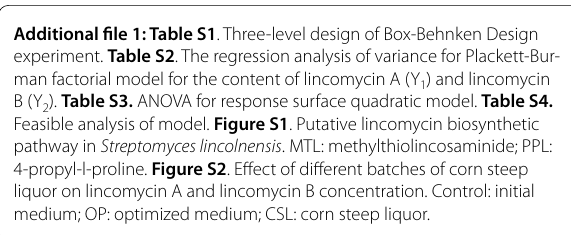
Additional file 1: Table S1 . Three‑level design of Box‑Behnken Design experiment. Table S2 . The regression analysis of variance for Plackett‑Bur‑ man factorial model for the content of lincomycin A (Y 1 ) and lincomycin B (Y 2 ). Table S3. ANOVA for response surface quadratic model. Table S4. Feasible analysis of model. Figure S1 . Putative lincomycin